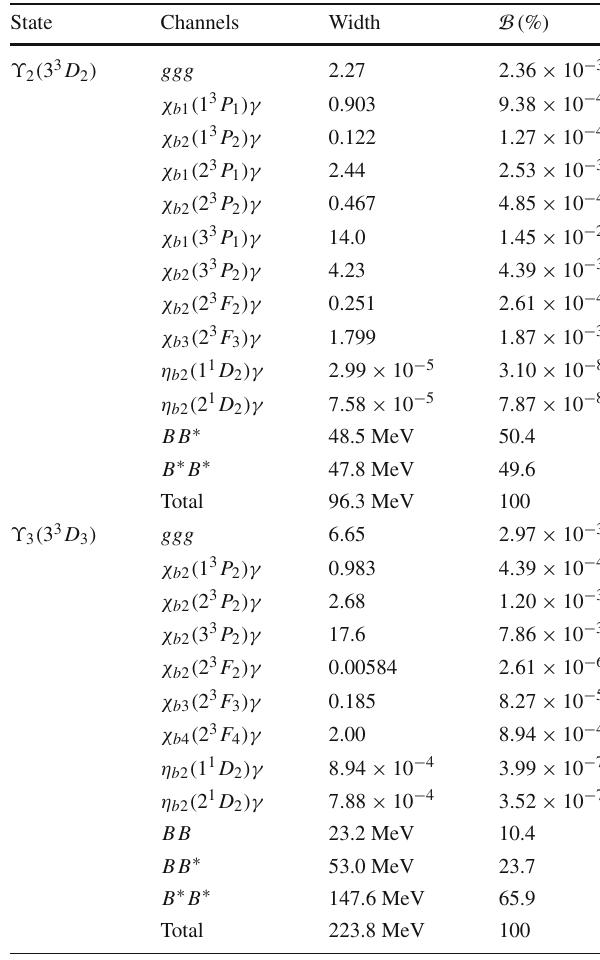
Table 28 Partial widths and branching ratios of OZI-allowed strong decay, annihilation decay, and radiative transition and total widths for 3 3 D 2 and 3 3 D 3 bottomonium states. The width results are in units